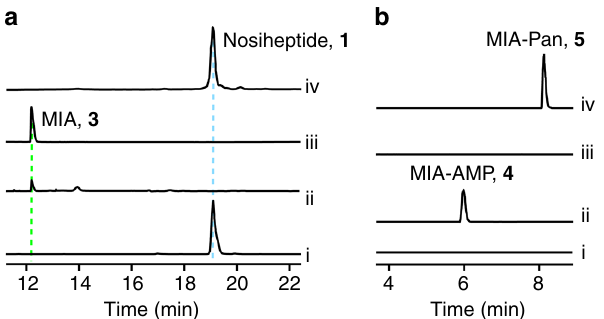
Fig. 2 NosI is an adenylating enzyme for MIA activation. a HPLC traces of the culture extracts from (i) S. actuosus wild-type strain, (ii) the nosI -knockout mutant and (iv) the nosI -knockout mutant containing a nosI -expressing plasmid; MIA synthetic standard (iii) was also analyzed to con fi rm the production of MIA by the nosI -knockout mutant. b LC-MS analysis of NosI in vitro activity, showing the extracted ion chromatograms (EICs) of [M+H] + = 505.1 (corresponding to MIA-AMP, 4 ) for (i) control reaction with the supernatant of boiled NosI, (ii) NosI reaction with MIA and ATP; and the EICs of [M+H] + = 436.2 (corresponding to the MIA-Pan, 5 ) for (iii) control reaction with the supernatant of boiled NosI and (iv) NosI reaction with MIA, ATP, and